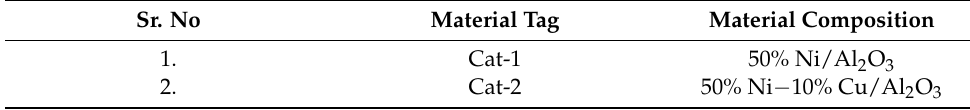
Table 1. The names and composition of the materials prepared. Sr. No Material Tag Material